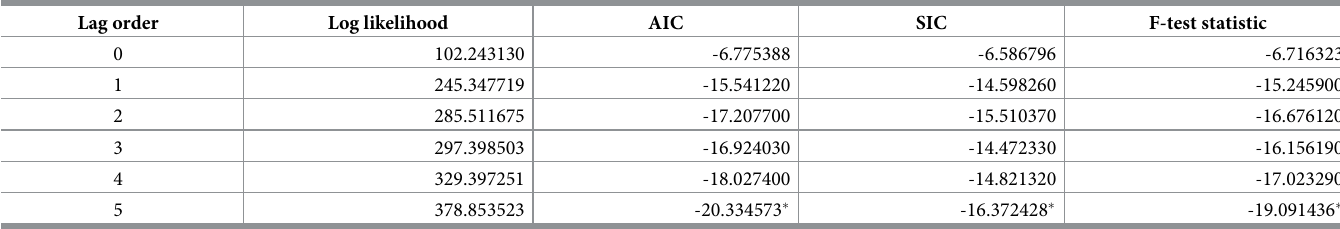
Table 2. Determine the lag order.